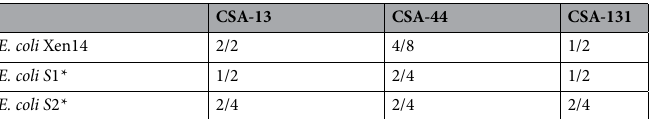
Table 1. Minimal inhibitory concentration and minimal bactericidal concentrations (MIC/MBC; µg/mL) of CSA-13, CSA-44 and CSA-131 against Escherichia coli Xen14 and two clinical strains of uropathogenic E. coli (S1 and S2) isolated from patients with urinary tract infections. *Clinical